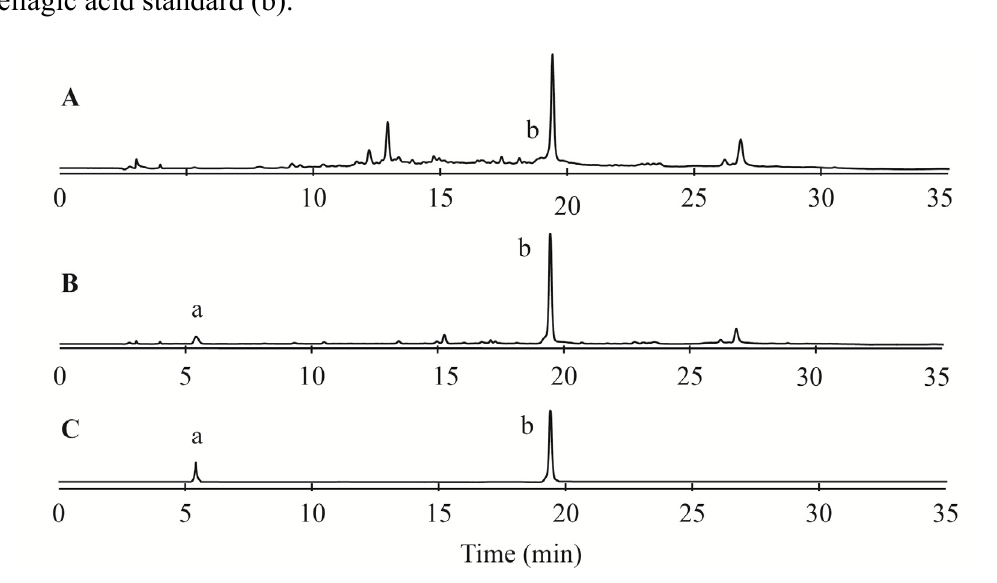
Figure 3. RP-HPLC profiles of CMPE before and after acid hydrolysis. ( A ) CMPE extract before acid hydrolysis; ( B ) CMPE extract after acid hydrolysis; ( C ) gallic acid standard (a) and ellagic acid standard